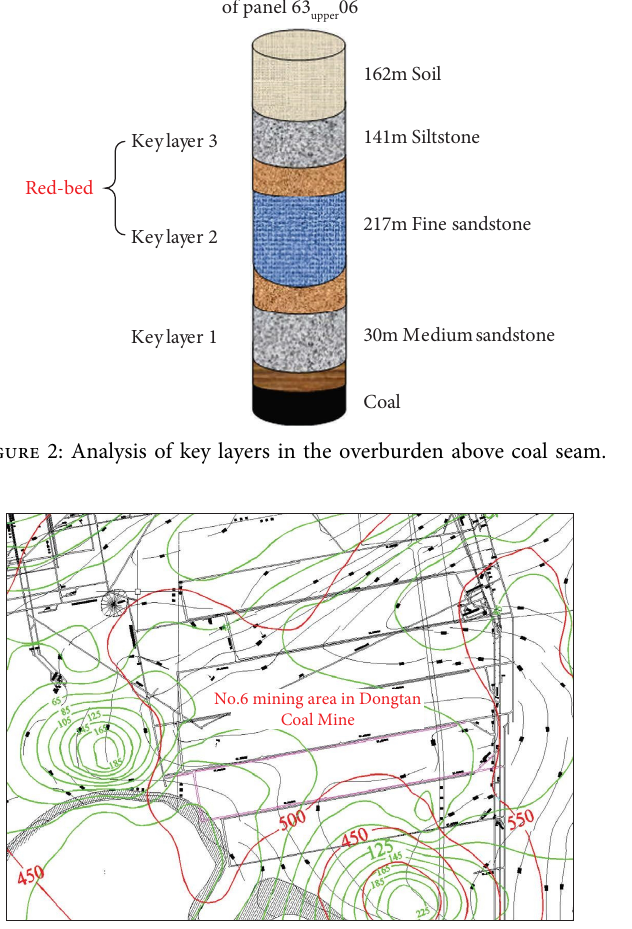
Figure 3: Distribution of the red-bed iso-thickness line (red), the red-bed bottom boundary, and the roof above coal seam iso-distance line